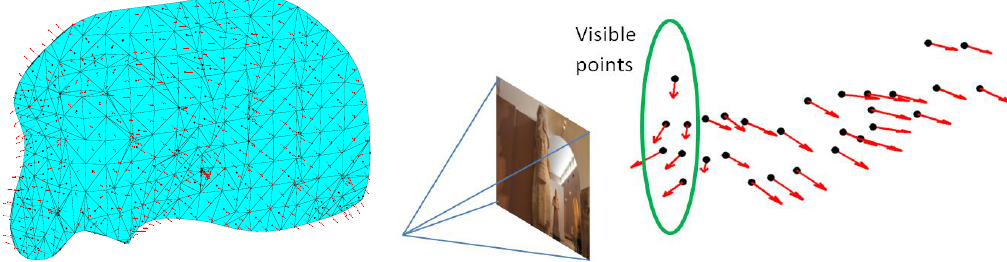
Figure 13. The uniform mesh of the rough model with surface normals for visibility